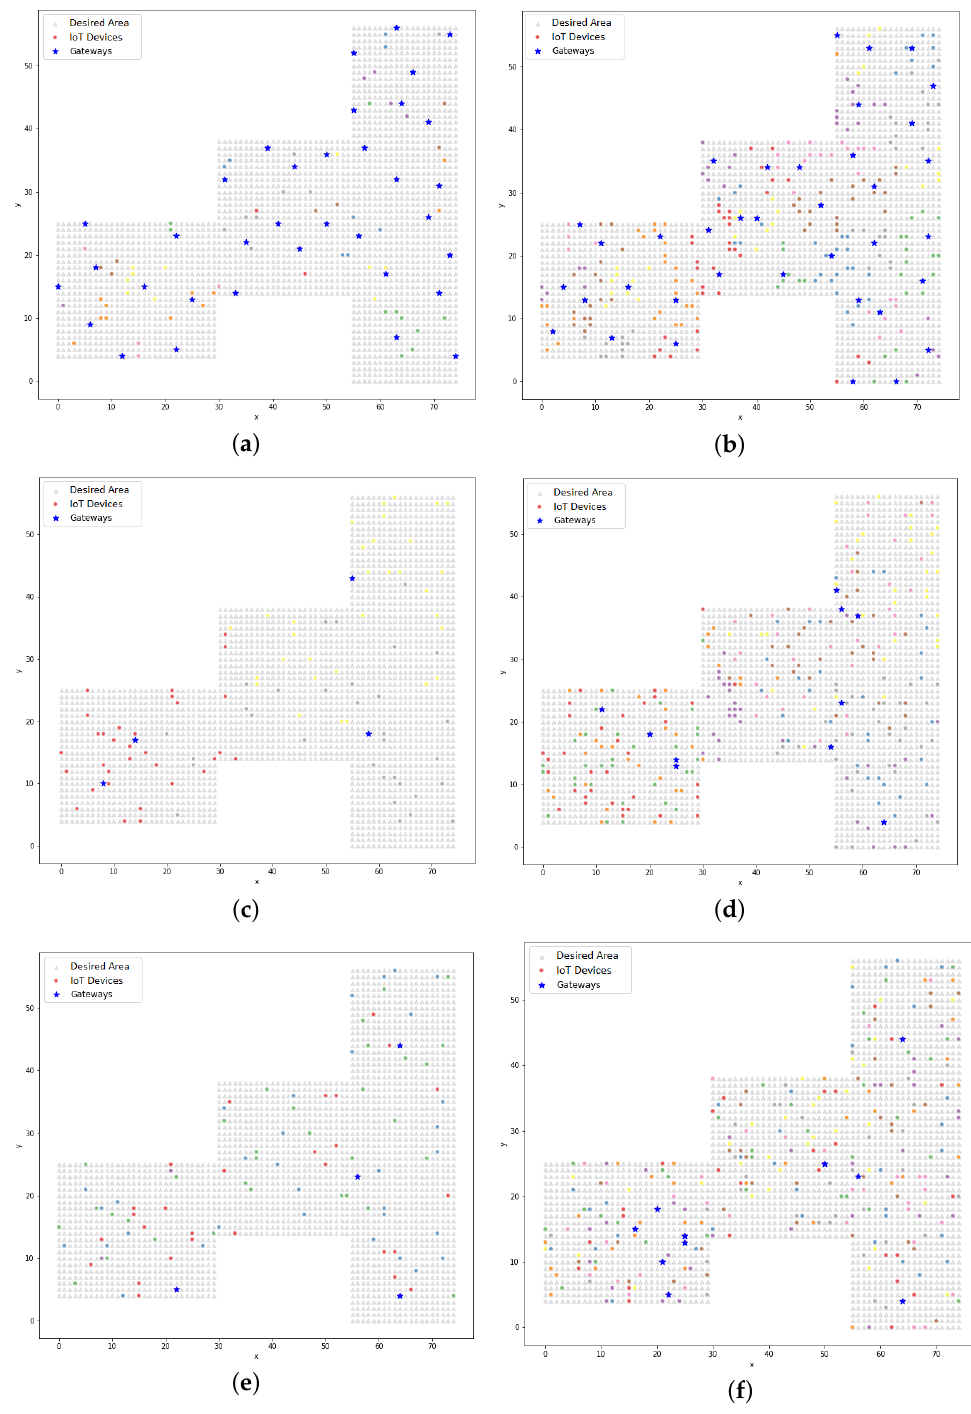
Figure 6. The plots of the devices and their respective gateways with a3% data link consumption (LP method): ( a ) BLE technology with 100 devices and 35 gateways; ( b ) BLE technology with 300 devices and 37 gateways; ( c ) Wi-Fi technology with 100 devices and 4 gateways; ( d ) Wi-Fi technology with 300 devices and 10 gateways; ( e ) LoRA technology with 100 devices and 4 gateways; ( f ) LoRA technology with 300 devices and 10